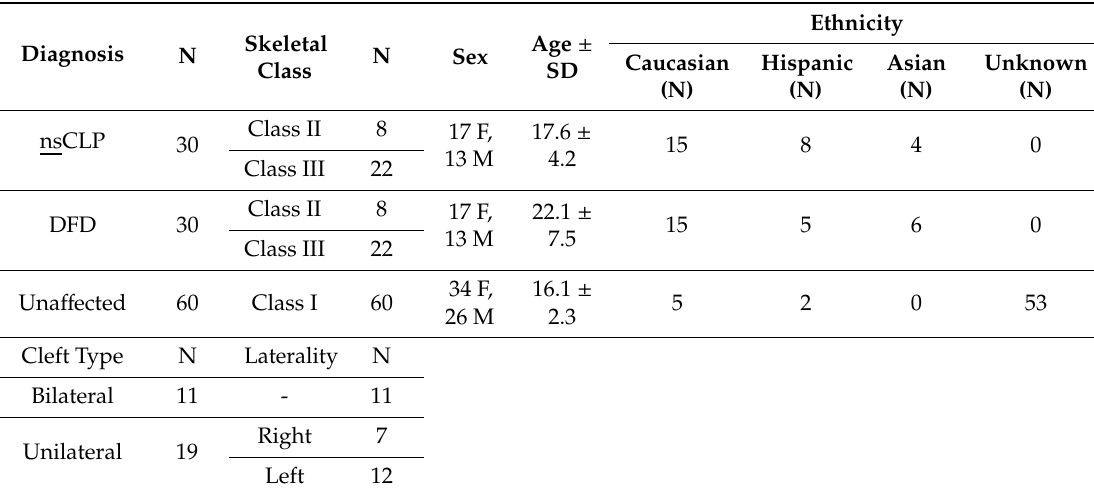
Table 1. Sample makeup indicating cohort type, number of individuals, sex, mean age, and ethnicity for all three groups and cleft type (unilateral or bilateral) and laterality (right, left, or bilateral) for nsCLP.